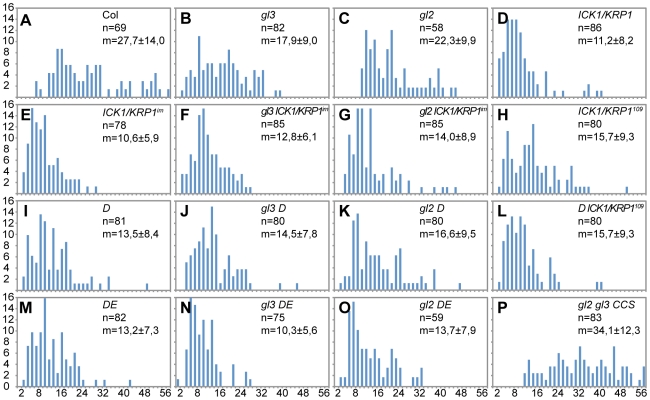
Analysis of DNA content in trichomes.(A–P) Distribution of the trichome DNA contents in relative fluorescence units (RFU). Two RFUs roughly represent 2C, calibrated with wild-type and gl3 trichome nuclei. (A) Wild type. (B) glabra3 (gl3). (C) glabra2 (gl2). (D) PROGL2:ICK1/KRP1. (E) PROGL2:GUS:YFP:ICK1/KRP1109-191 (ICK1/KRP1im). (F) gl3 - ICK1/KRP1im. (G) gl2 - ICK1/KRP1im. (H) PROGL2:ICK1/KRP1109–191. (I) CDKA;1T161D (D). (J) gl3 - D. (K) gl2 - D. (L) D - PROGL2:ICK1/KRP1109–191. (M) CDKA;1T14D/Y15E (DE). (N) gl3 - DE. (O) gl2 - DE. (P) gl2 - gl3 - PROGL2:CCS52A1.